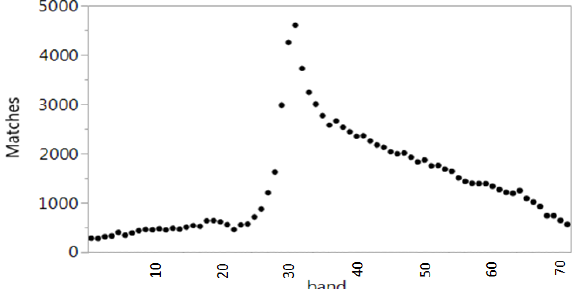
Figure 13. Number of points matched between the reference band 31 and other spectral bands using optimized SIFT parameters.